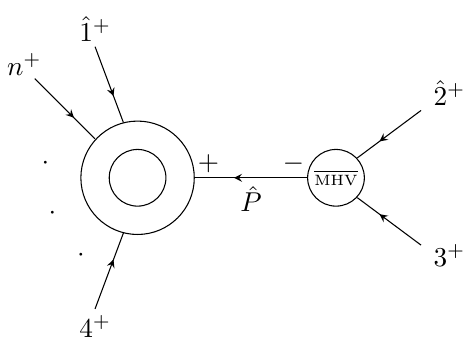
Figure 2. Diagram contributing to the BCFW recursion (6.14) for the one-loop all-plus amplitude. The n -gluon one-loop all-plus amplitude factorises into the ( n (cid:0) 1)-gluon one, on the left, and the three-gluon anti-MHV amplitude, on the